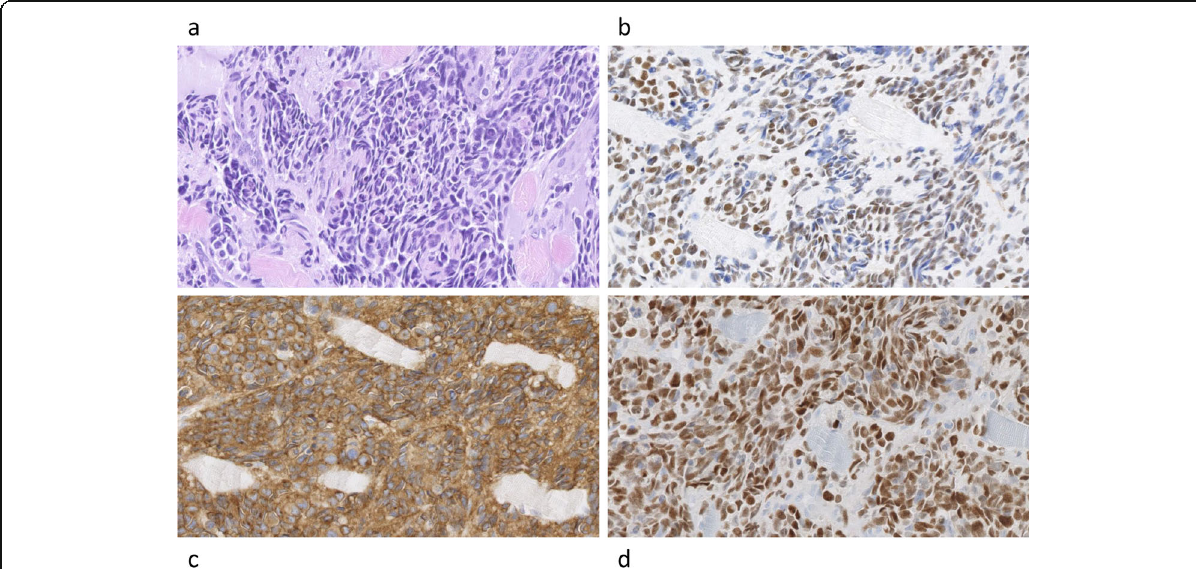
Fig. 1 Fusion PAX3-FOXO1 positive tumour with positive immunohistopathological markers. Legend: ARMS tumour showing HE staining ( a ), positive reactions for expression of TFAP2B ( b ), ALK ( c ) and OLIG2 ( d ). Images were scanned at original magnification 40x. Digital magnification is